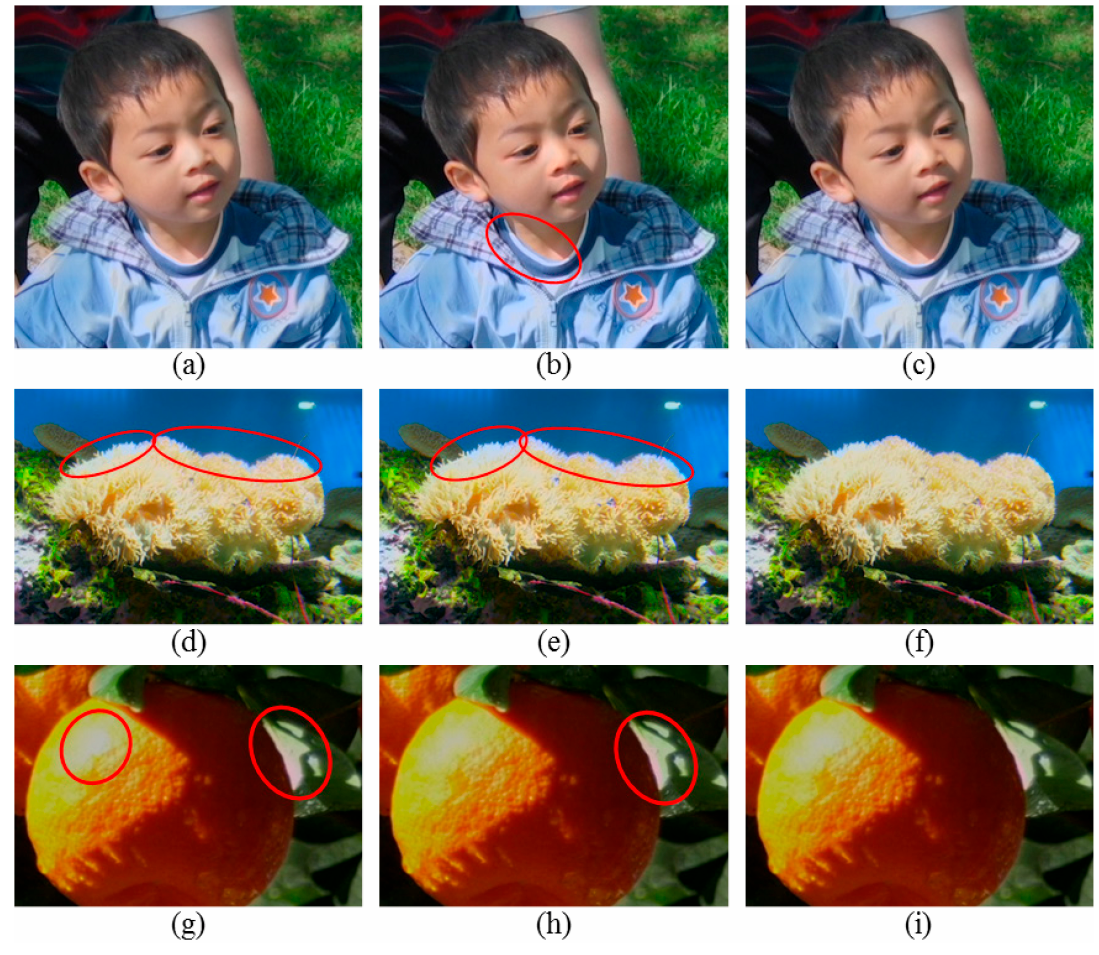
Figure 7. Comparison of correction results for an over-exposure. The OERs in ( a ), ( d ), and ( g ) were detected using the brightness thresholding method (Y ≥ 230) [9]. The OERs in ( b ), ( e ), and ( h ) were detected using the over-exposed map based thresholding method [10]. The OERs in ( c ), ( f ), and ( i ) were detected using the proposed method. All OERs were corrected using Guo’s method [10]. The results are best viewed in the electronic